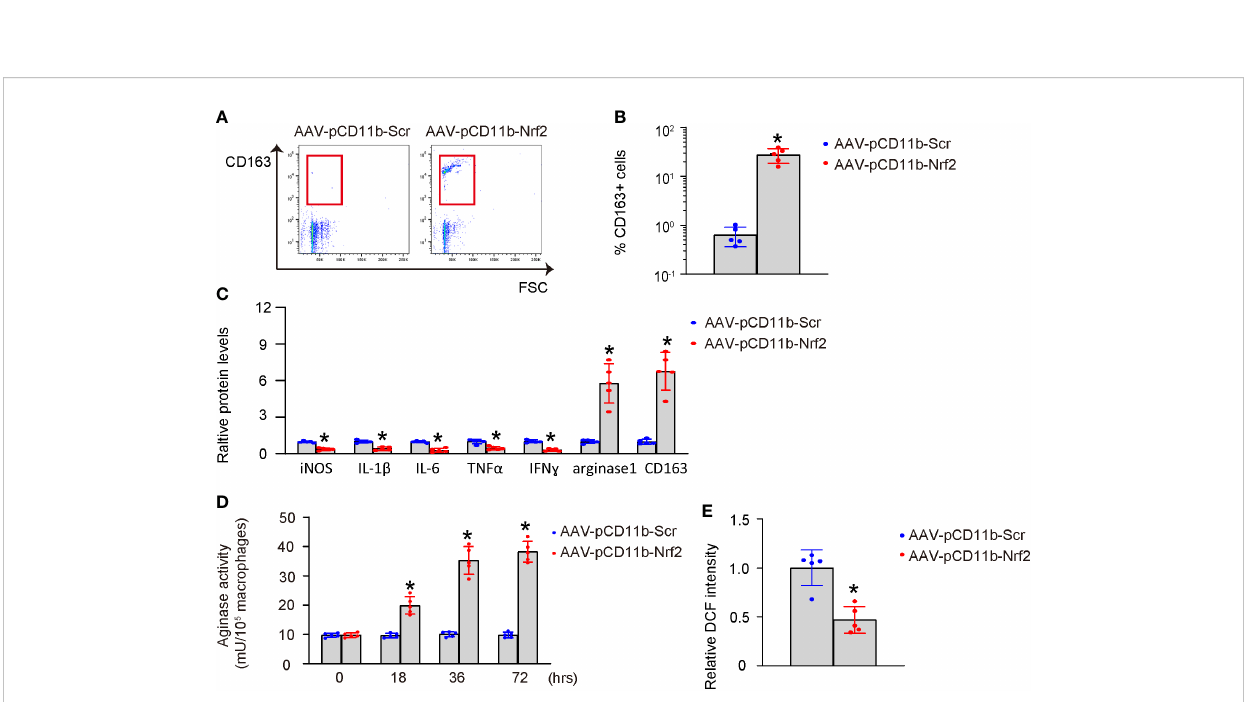
FIGURE 4 Nrf2 induces M2-like polarization of macrophages. BMDMs were transduced with AAV-pCD11b-Nrf2 or control AAV-pCD11b-Scr. (A, B) Flow cytometry for CD163 expression of transduced BMDMs, shown by representative fl ow charts (A) and by quanti fi cation (B) . (C) ELISA for iNOS, IL-1 b , IL-6, TNF a , IFN ɣ , arginase 1 and CD163 in transduced BMDMs. (D) Arginase activity. (E) ROS production. *p<0.05.